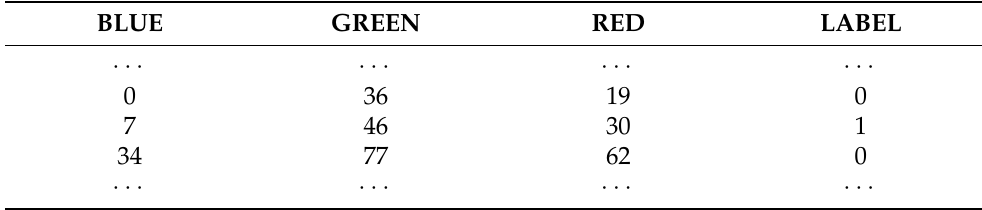
Table 1. Data set